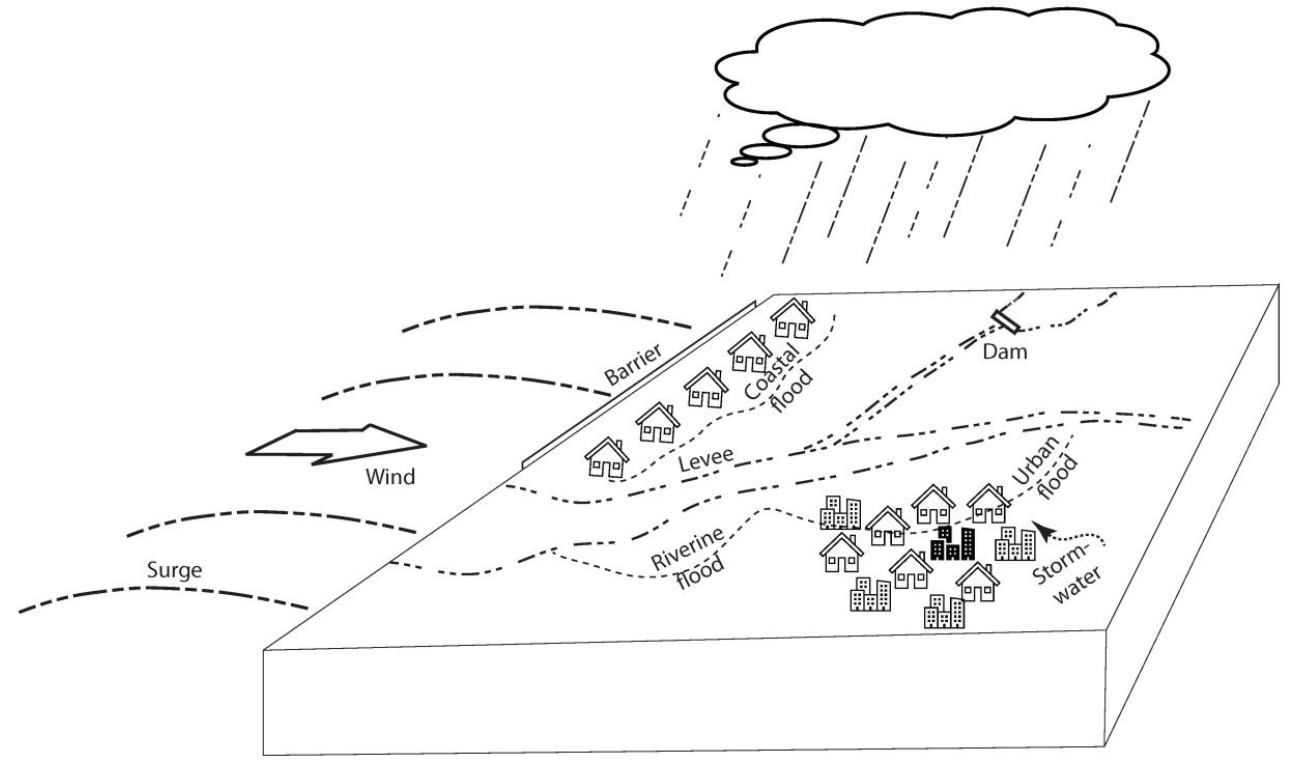
Figure 1. Reference diagram showing locations of riverine and coastal flood risks.